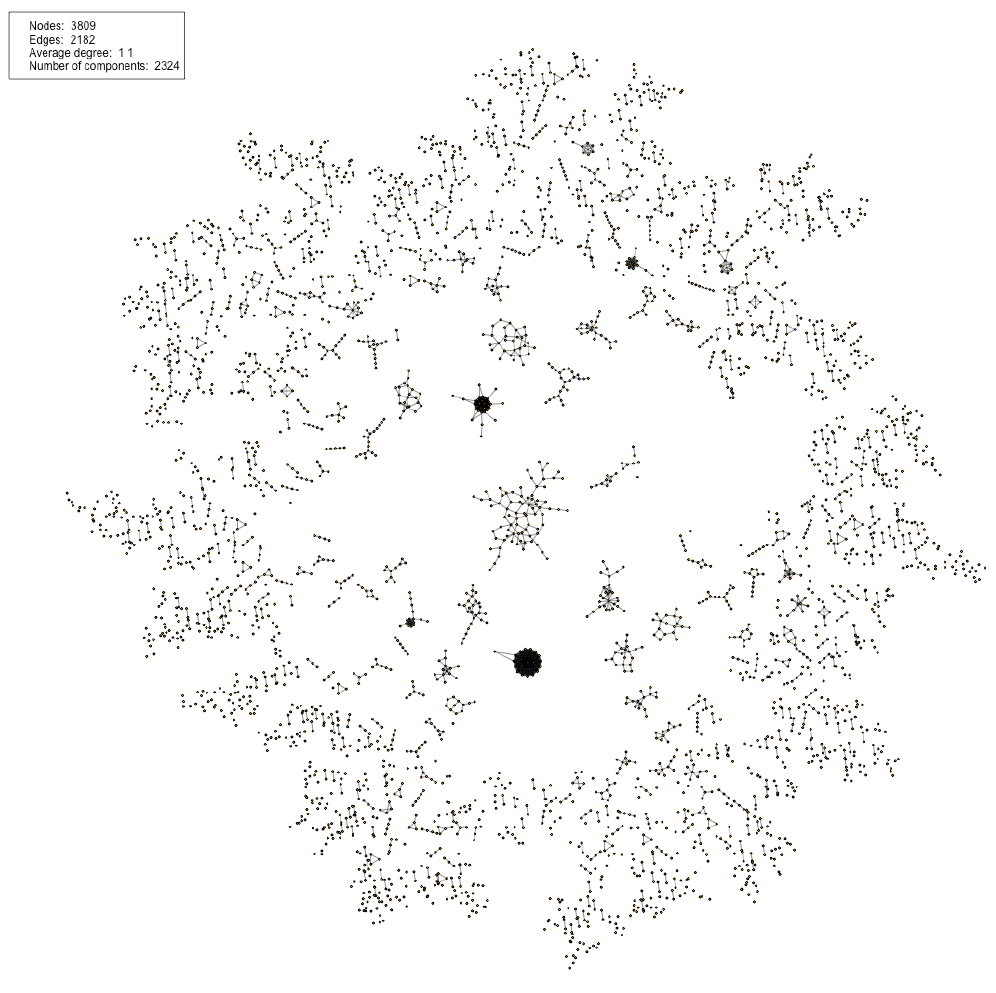
Figure 15. Channel network for